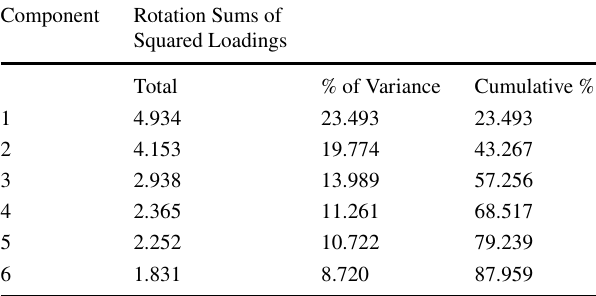
Table 8 Total variance